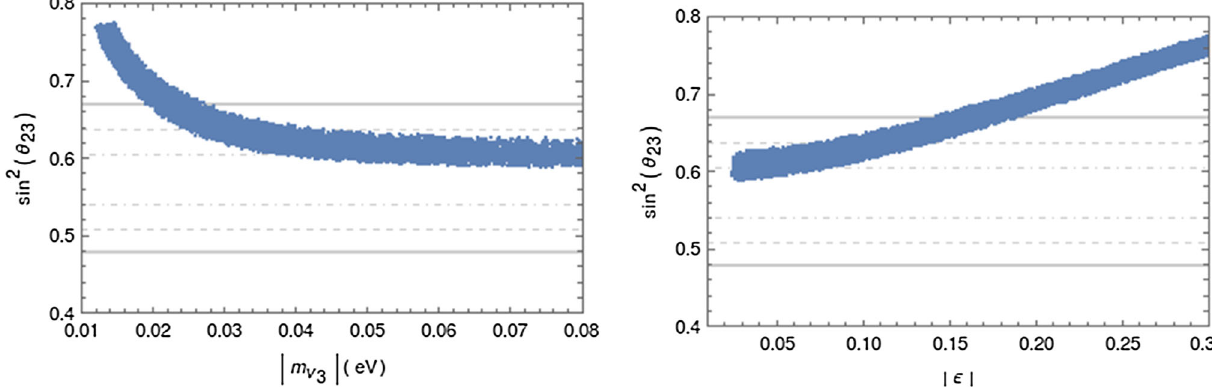
Fig. 2 Case D : Allowed region for sin 2 θ 23 . The dot-dashed , dashed and thick lines stand for 1 σ , 2 σ and 3 σ of C. L = r A r A cos 2 θ ν + r A sin 2 θ ν 3 2 1